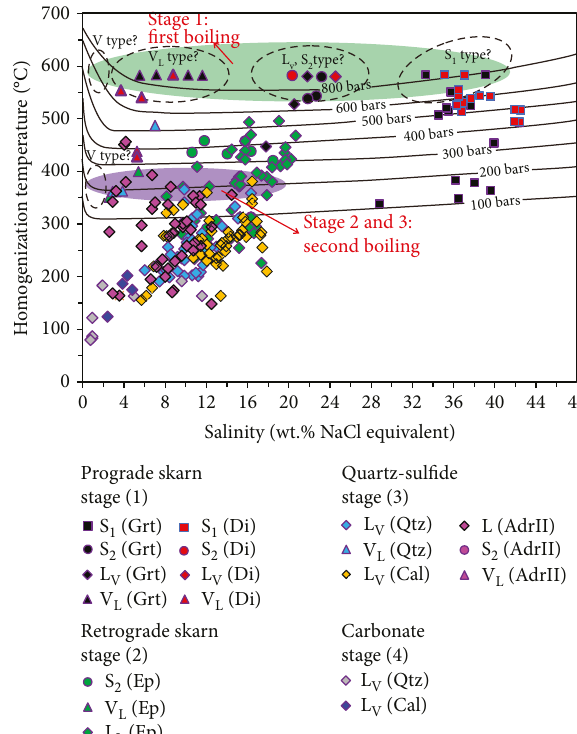
Figure 12: Pressure estimation for fl uid inclusions in di ff erent stages (NaCl-H O system). The green ellipse represents fl uid 2 inclusions trapped under fi rst boiling conditions in the prograde skarn stage, while the purple ellipse represents fl uid inclusions trapped under second boiling conditions both in retrograde skarn and quartz-sul fi de stages. Hence, estimated pressures can be representative of actual trapping pressures for both of them. Particularly, other plotted data represent the minimum trapping pressures. Isobars were calculated from the equations of Driesner and Heinrich